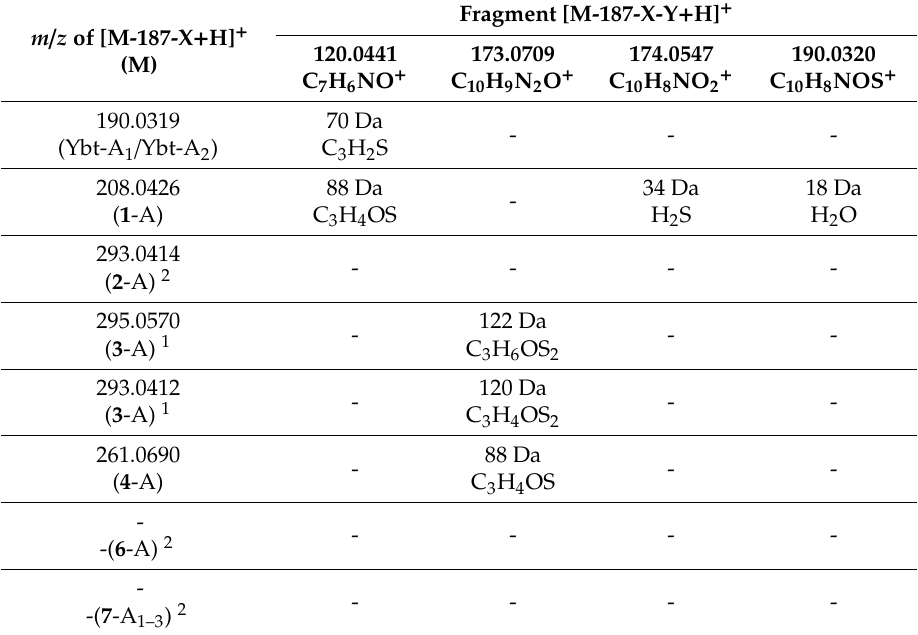
Table 7. Selected fragments caused by di ff erent NLs recorded during MS 4 experiments of Ybt and its novel derivatives by application of LC-HRMS. All recorded fragmentation spectra are shown in the Supplementary Material. The specific NLs [X] refer to the NLs shown in Tables 5 and 6. These NLs combined with the specific NLs [Y] listed in this table lead to the fragment ions [M-187-X-Y + H] + listed on top of the